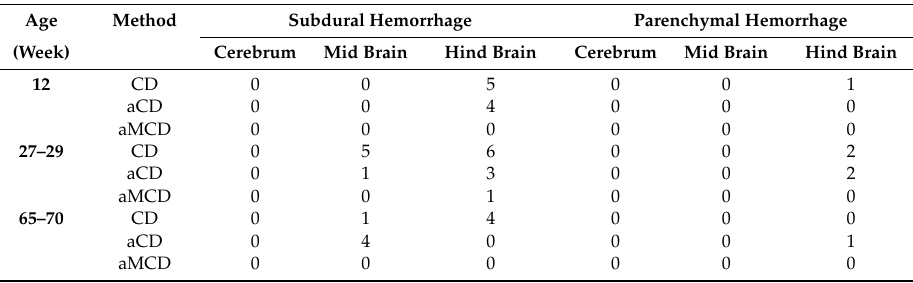
Table 11. Summary of microscopic scoring of brains for trauma following application of each of the three killing methods in layer chickens. Number of birds with hemorrhage (any score > 0) in each section are indicated.